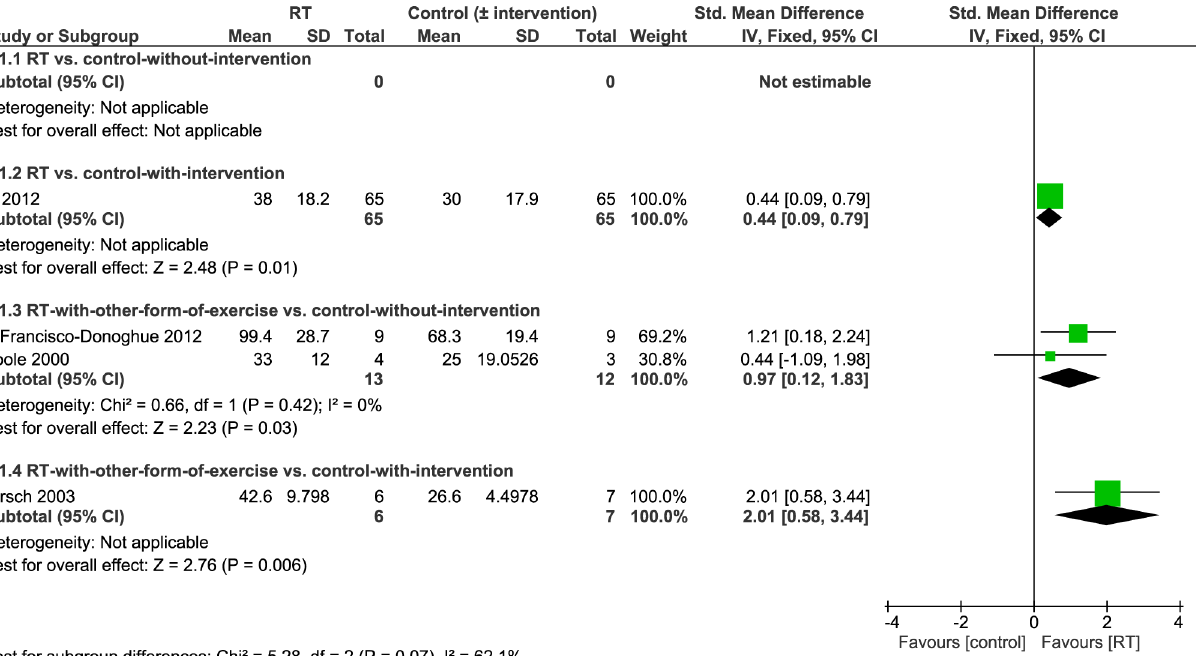
Fig 7. Subgroup analysis forest plot of comparison: RT vs. control-without-intervention, RT vs. control-with-intervention, RT with other form of exercise vs. control-without-intervention, RT with other form of exercise vs. control-with-intervention, using post-intervention values. Outcome: knee flexion strength. CI = confidence interval; IV = inverse variance; SMD = standardized mean difference.